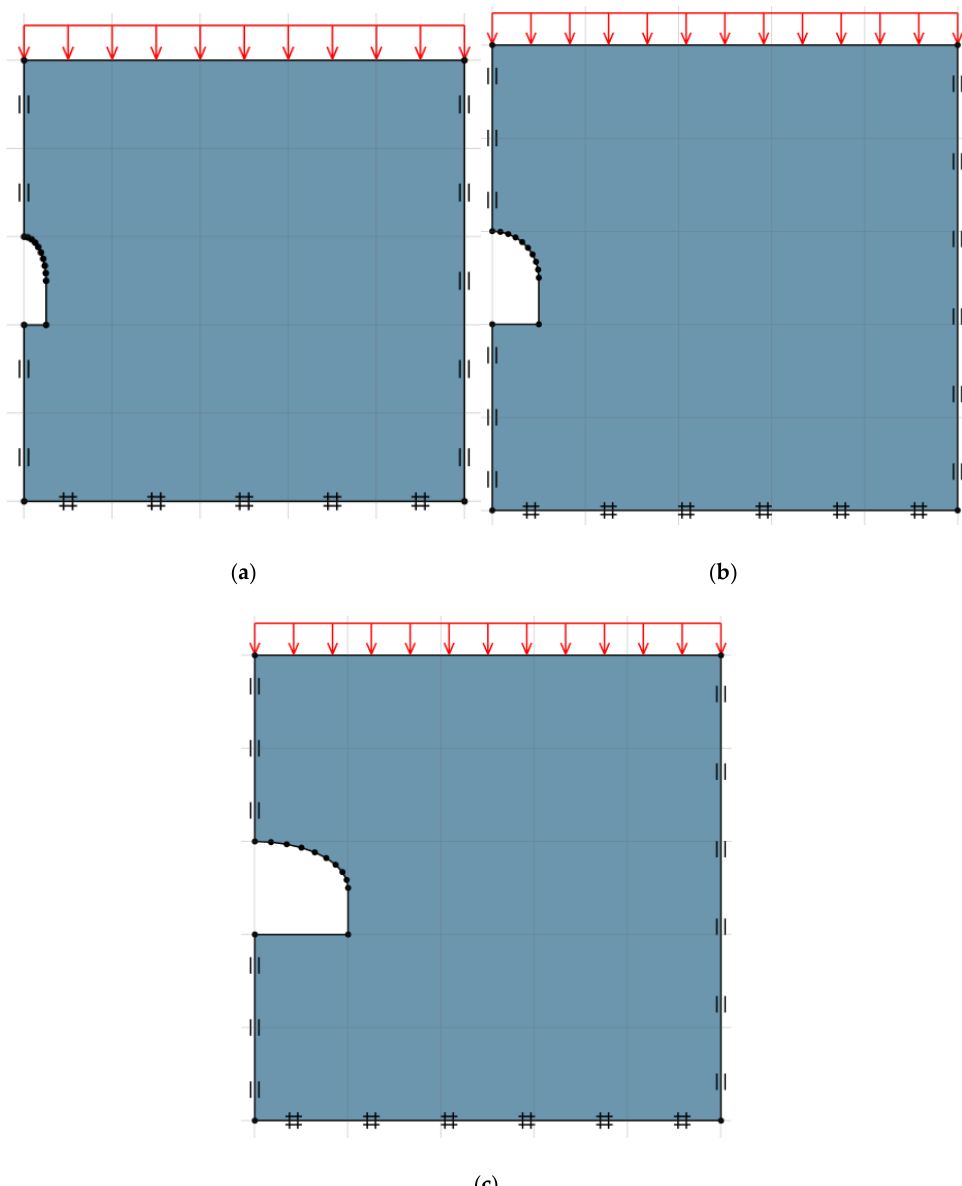
Figure 2. A numerical model of horseshoe tunnel: ( a ) B / D = 0.5, ( b ) B / D = 1 and ( c ) B / D =